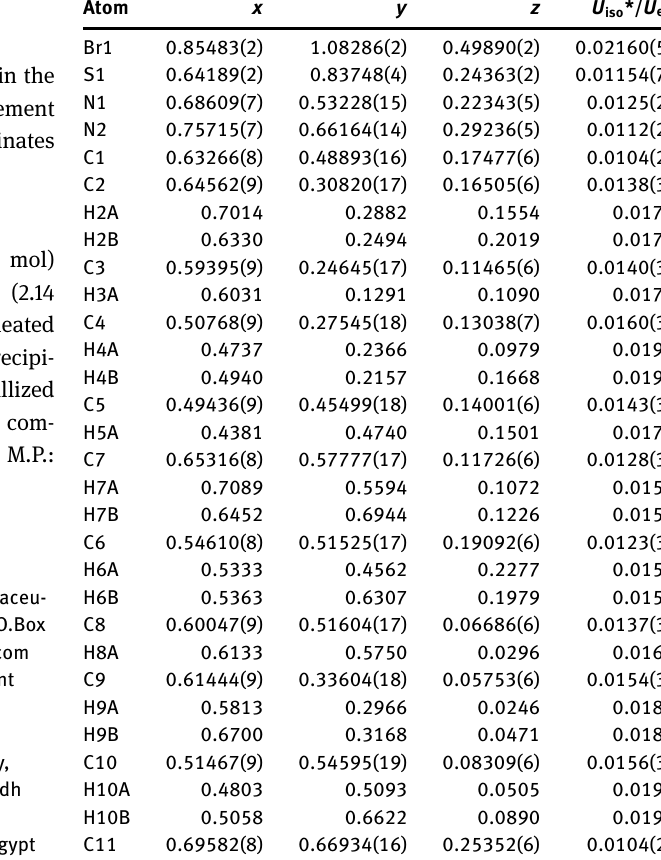
Table 2: Fractional atomic coordinates and isotropic or equivalent isotropic displacement parameters (Å 2